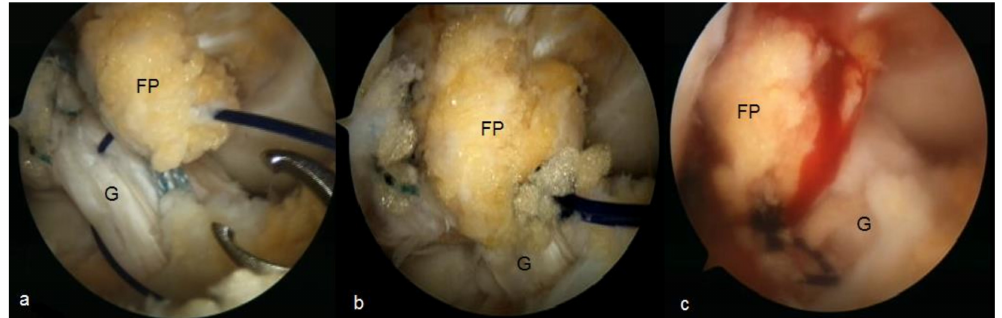
Figure 4. Synovialization enhancement technique with a pedunculated posterior cruciate ligament (PCL) fat pad: ( a ) Pedun- culated fat pad (FP) sutured to the anterior cruciate ligament (ACL) graft (G) with an PDS suture; ( b ) Central part of a graft covered with a fat pad; ( c ) Formation of a hematoma on a surface of the graft after tourniquet release.